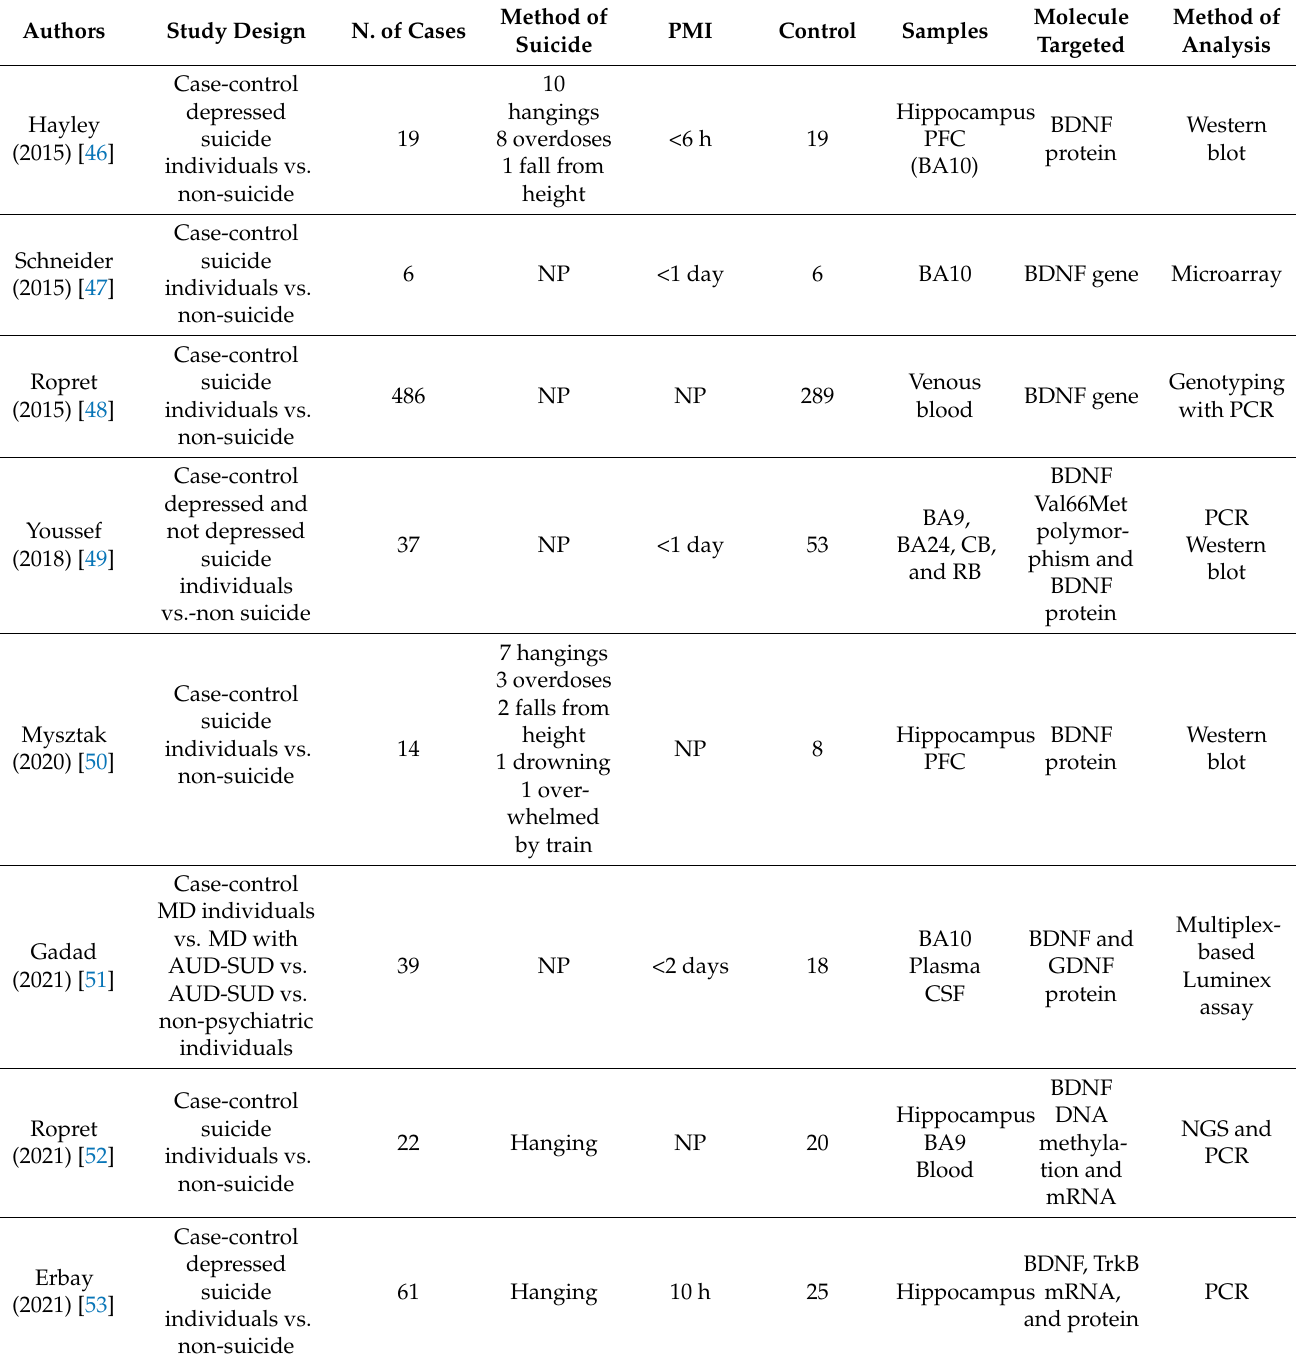
Table 1. Characteristics of the analyzed